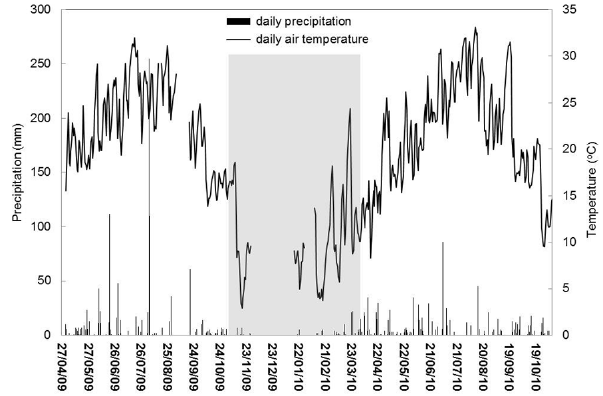
Fig. 2. Daily average air temperature and daily precipitation at TSP. The temperature data from 5 September to 18 September 2009, 29 November 2009 to 16 January 2010 and 29 January to 8 Febru- ary 2010 were missing. Shaded area indicates the dry-cool season.